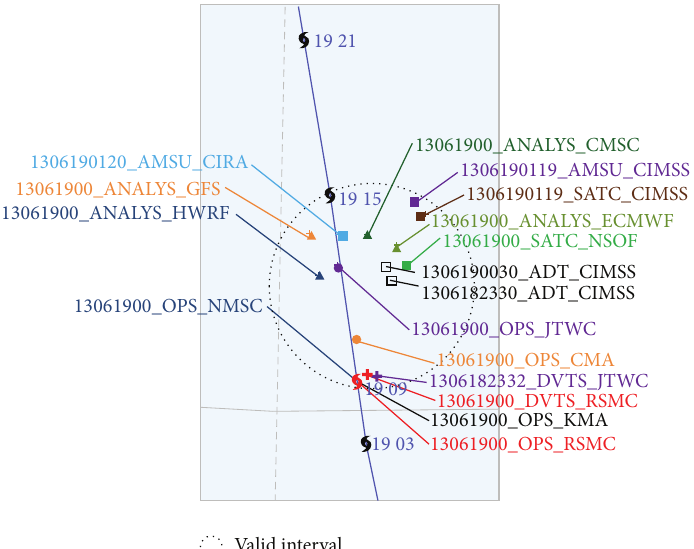
Figure 4: Overlaying the fixed data (markers) and the valid interval (circle) on track chart at 00 UTC on 19 June, 2013, for Typhoon LEEPI (1304). Each fixed data (marker) comes in different color and shape with each text. It was written in the form as the detected date the name of used data or imager the name of agency . Please refer to the list of abbreviations in Table 1. The red and black typhoon symbols denote the center positions at 00 UTC on 19 June and other times.